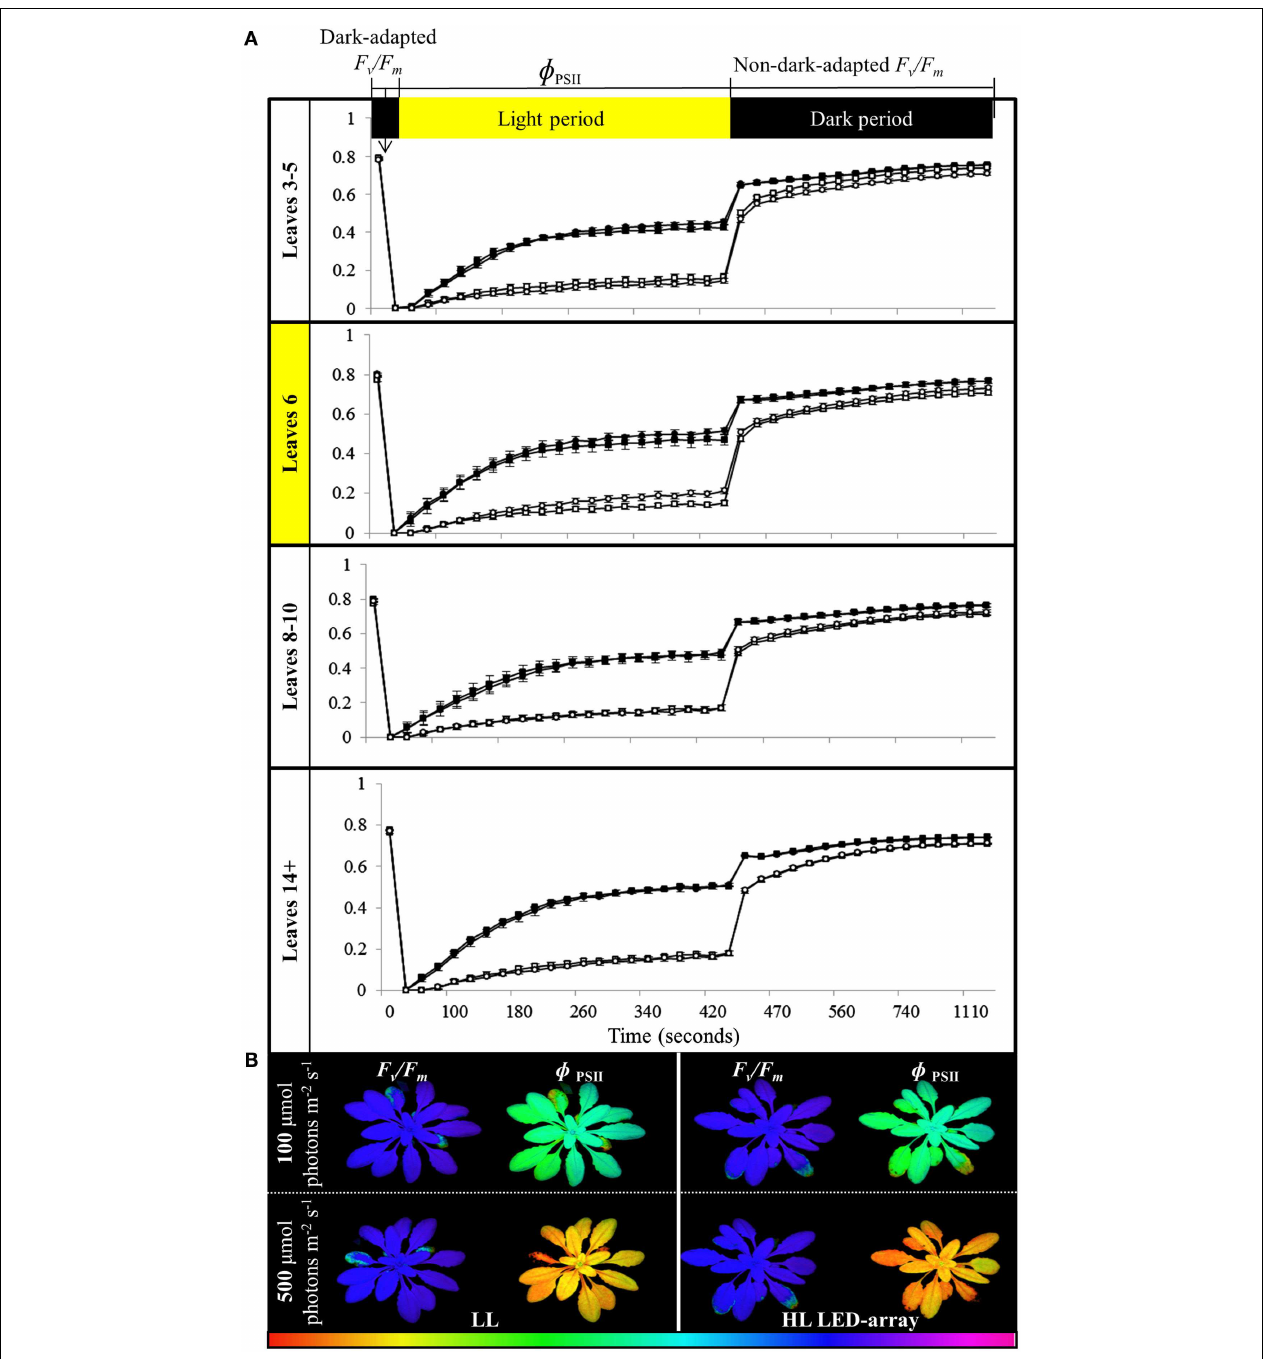
the indicated time are shown.The leaf position is indicated.The entire experiment was performed in triplicate, one representative is shown for which n = 3. (B) A representative false colour image of F v /F m and φ PSII (measured at 420s) from HL LED-array exposed (HL) and untreated (LL) plants under 100 and 500 µ molphotonsm − 2 s − 1 .The colored scale bar represents the corresponding value of φ PSII or F v /F m , increasing in value from left (red) to right